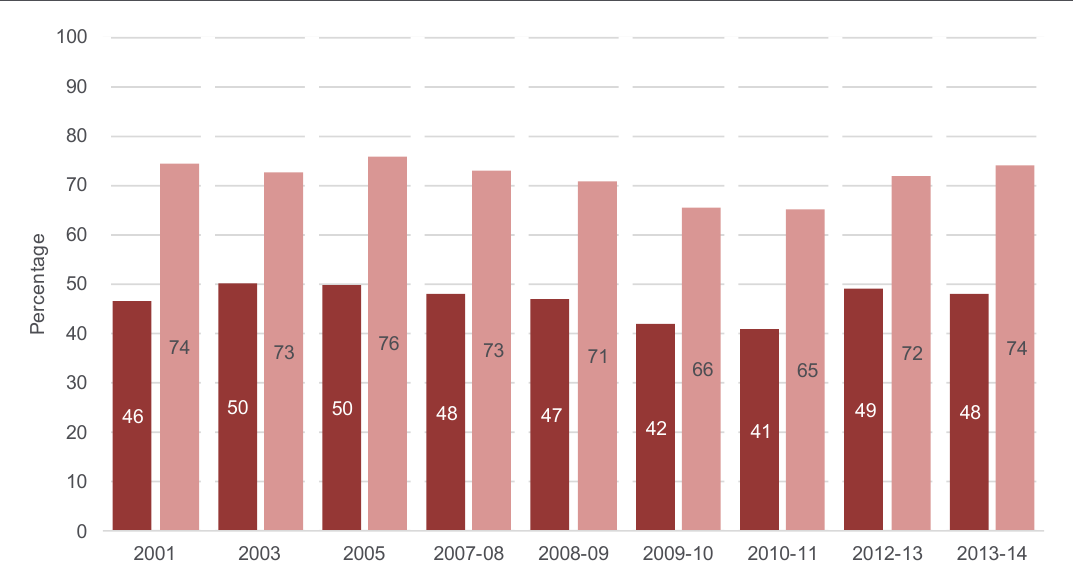
Figure 1: Whether people had participated in any volunteering, 2001 to